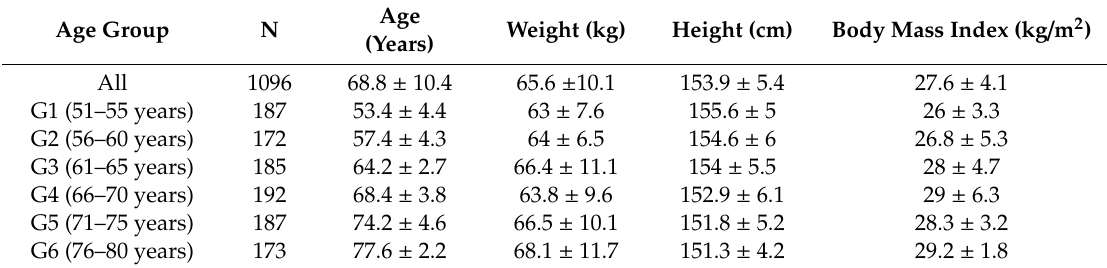
Table 1. Descriptive statistics of anthropometric variables (data provided: mean ± standard deviation).